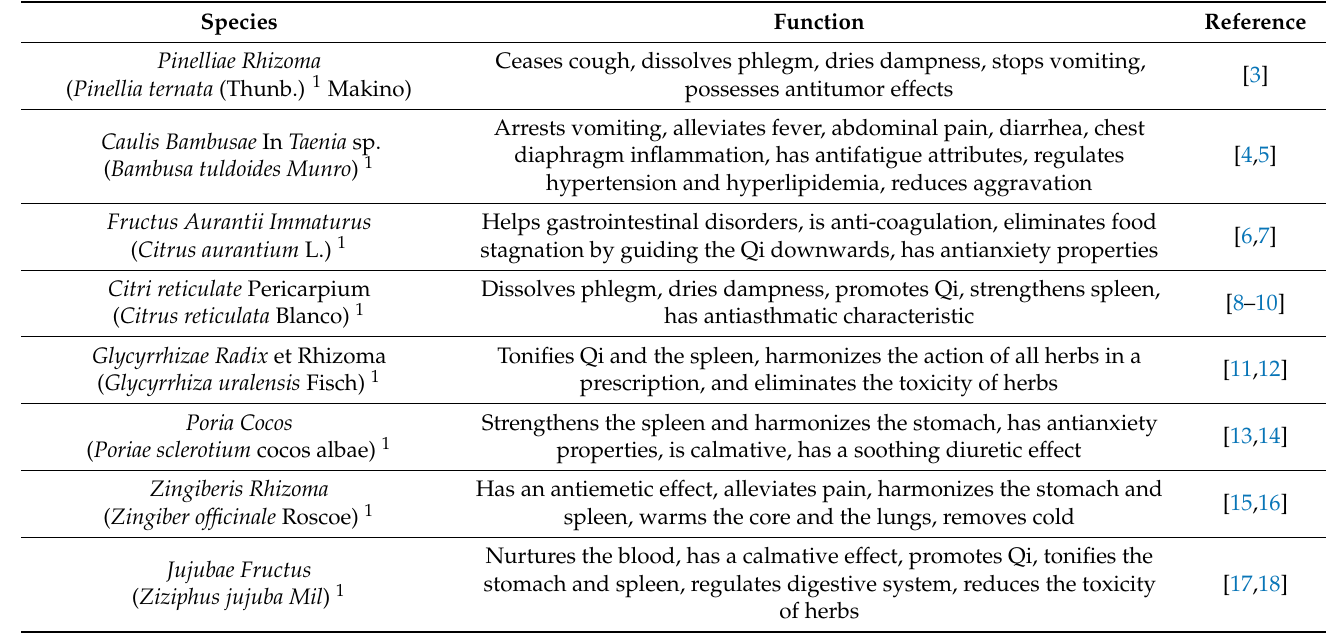
Table 1. WDT herbal components species and function.